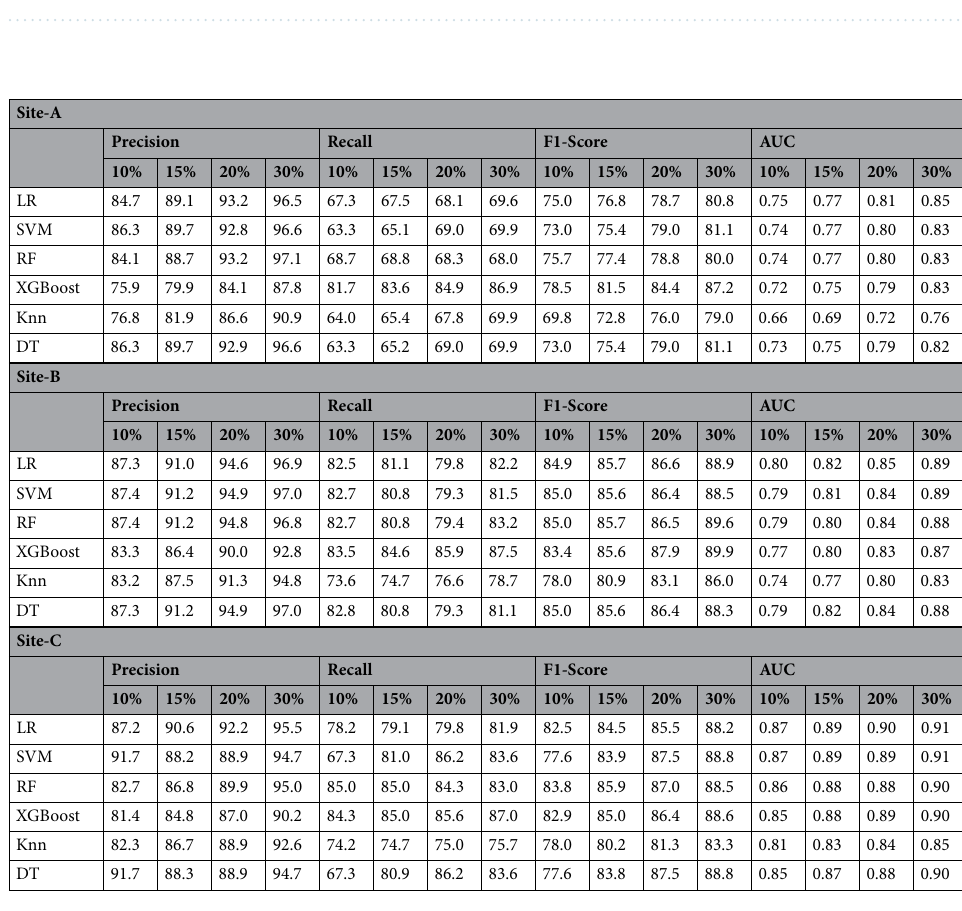
Table 3. Performance of various ML models in classifying patients with increased EF values from those patients with either decreased or stable EF over the same period.